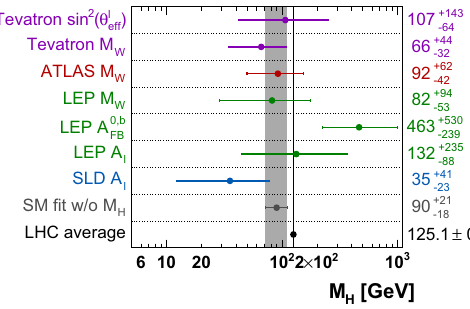
Fig. 4 Comparison of the constraints on M H obtained indirectly from individual observables with the fit result and the direct LHC measure- ment. For the indirect determinations among the four observables pro- viding the strongest M H constraints (namely sin 2 θ (cid:3) A (cid:3) ) only the one indicated in a given row of the plot is included in the fit. The results shown are not fully